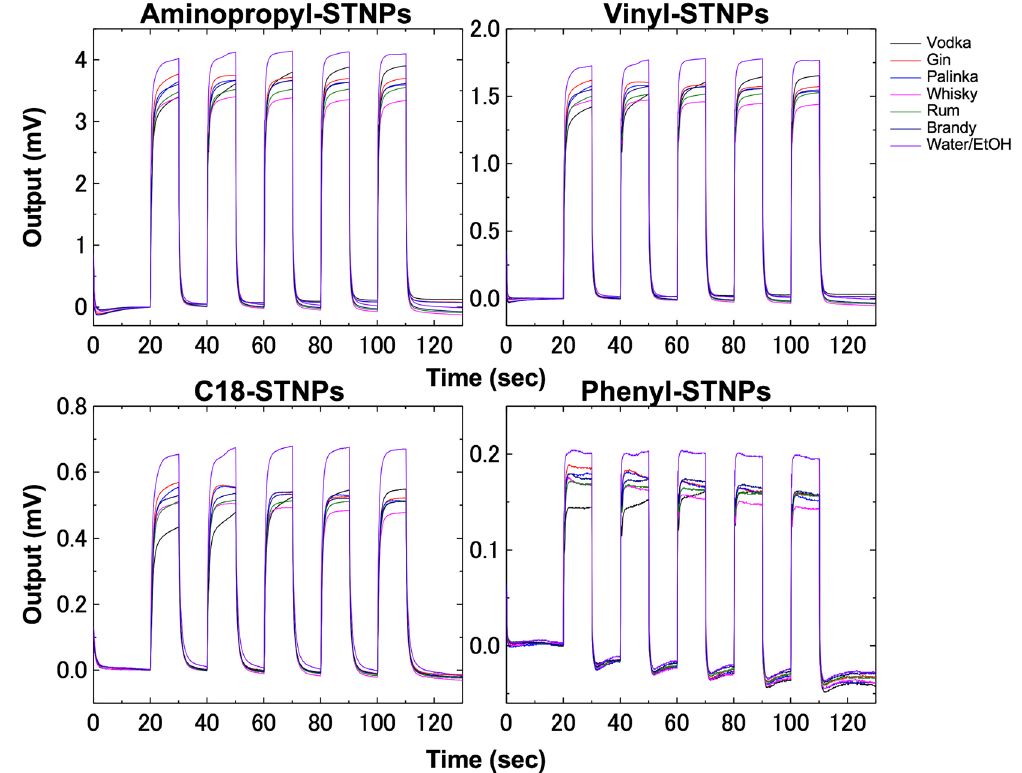
Figure 6. Response signals from the liquid samples with the same alcohol content (40%). The shape/intensity of the responses are different even with the same alcohol content because of the difference in other various components such as flavors.